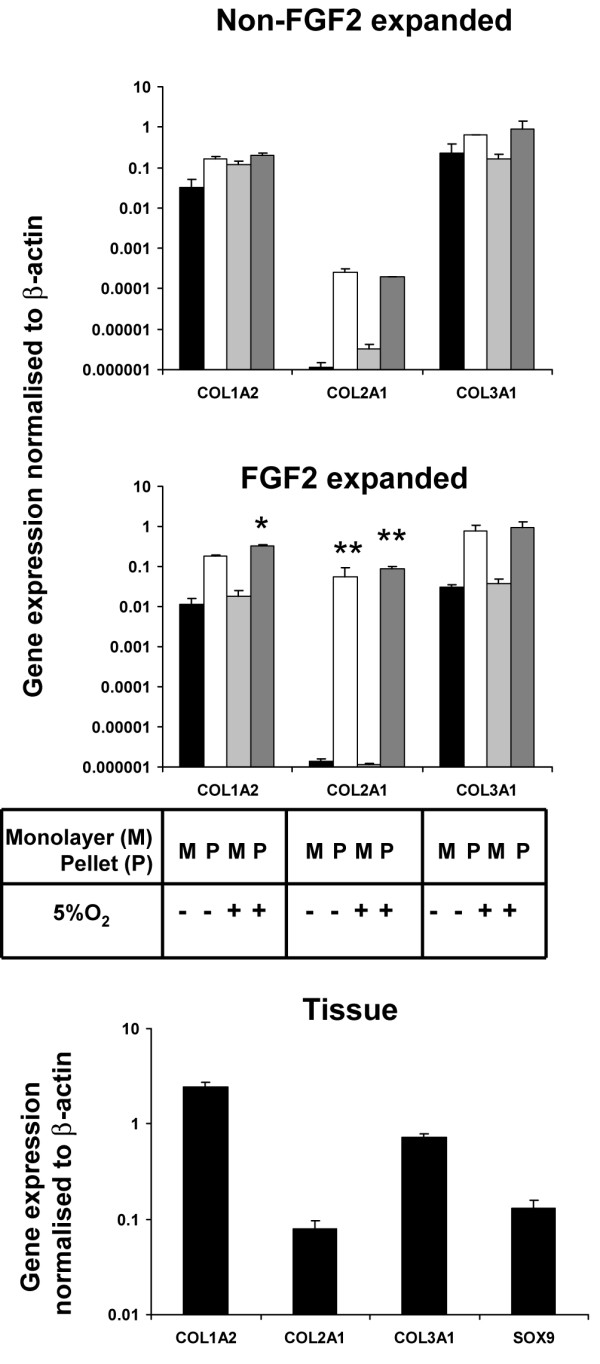
Collagen expression in monolayer and cell aggregate cultures, and in meniscus tissue with SOX9 expression (n = 3). Gene expression levels for monolayer cells (light grey bars) between P2 and P3 in standard medium (n = 3) and for cell aggregate (dark grey bars) cultures in chondrogenic differentiation medium (n = 3) under low oxygen tension after 14 days in culture. *p < 0.05; **p < 0.001 (Student's unpaired t test) in cell aggregates from fibroblast growth factor 2 (FGF2)-expanded versus non-FGF2-expanded cells.